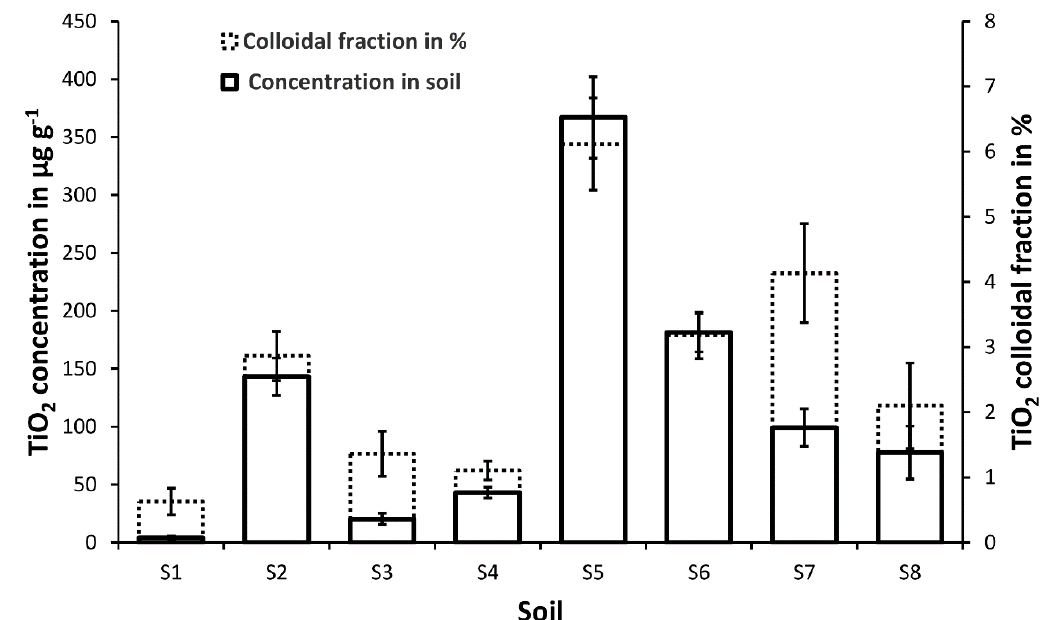
Figure 2. Concentration of TiO 2 in the investigated soils determined using XRFA (total content, dashed lines) and ICP-OES after piranha acid digestion and centrifugation (soluble fraction, full lines). The length of the error bars corresponds to two times the standard deviation determined for three sample replicates.